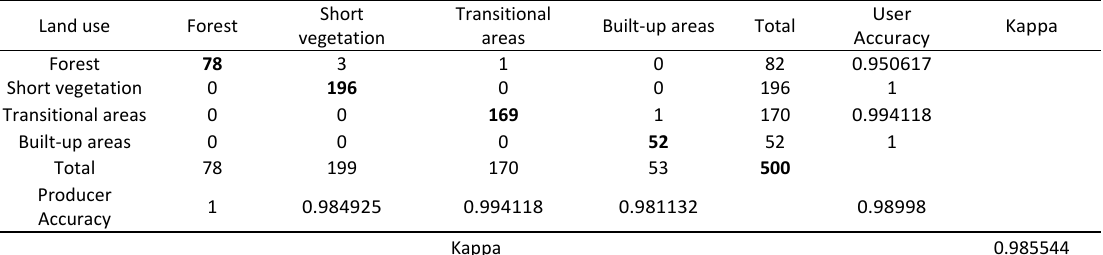
Table 2 Confusion matrix for 2005 classification